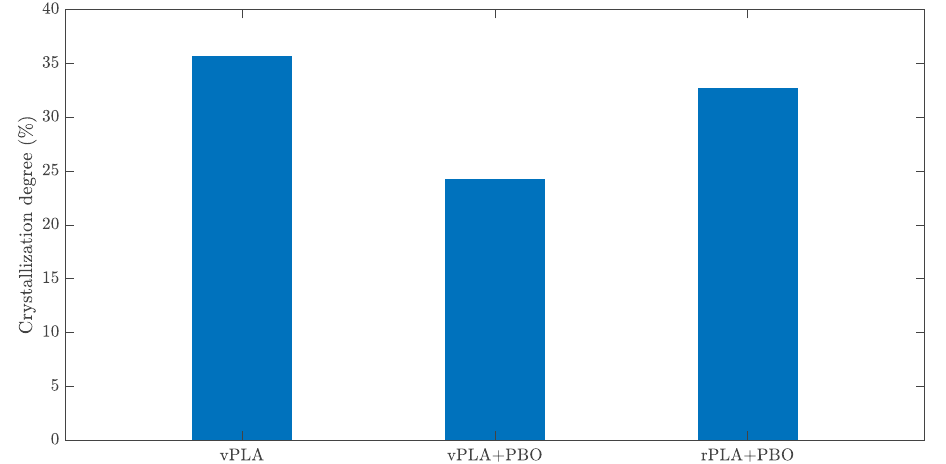
Figure 8. Representation of the crystallization degree for virgin PLA (vPLA), virgin PLA mixed in the presence of PBO (vPLA+PBO), and recycled PLA mixed in the presence of PBO (rPLA+PBO).